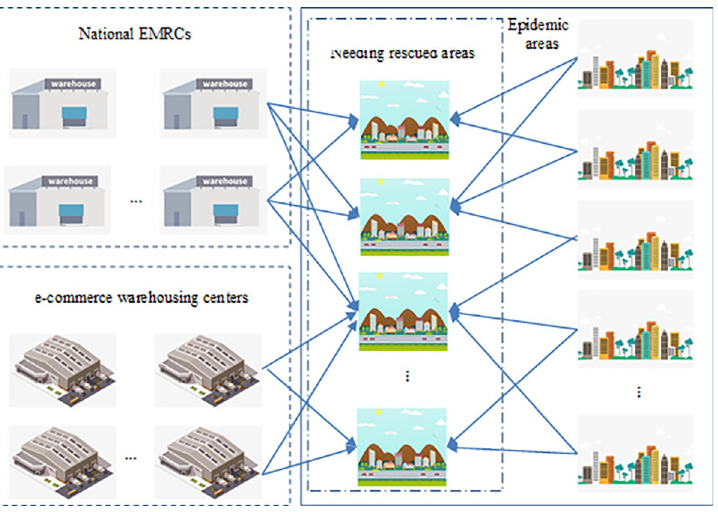
Fig 1. Conceptual framework of the specified emergency medical logistics